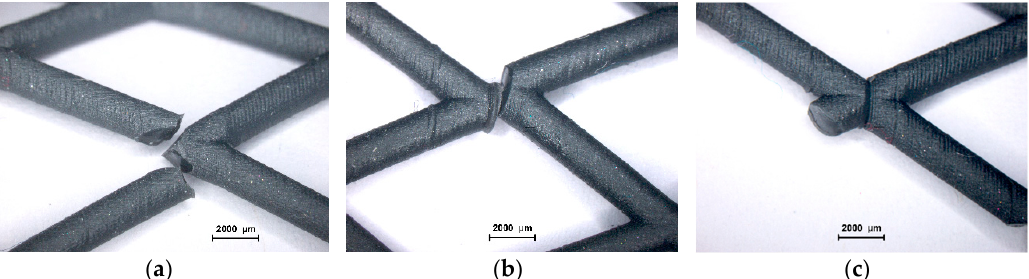
Figure 12. Failure pattern on geometrical notches ( a ), on printing misalignments along printing layers ( b ), and on topological notches ( c ).